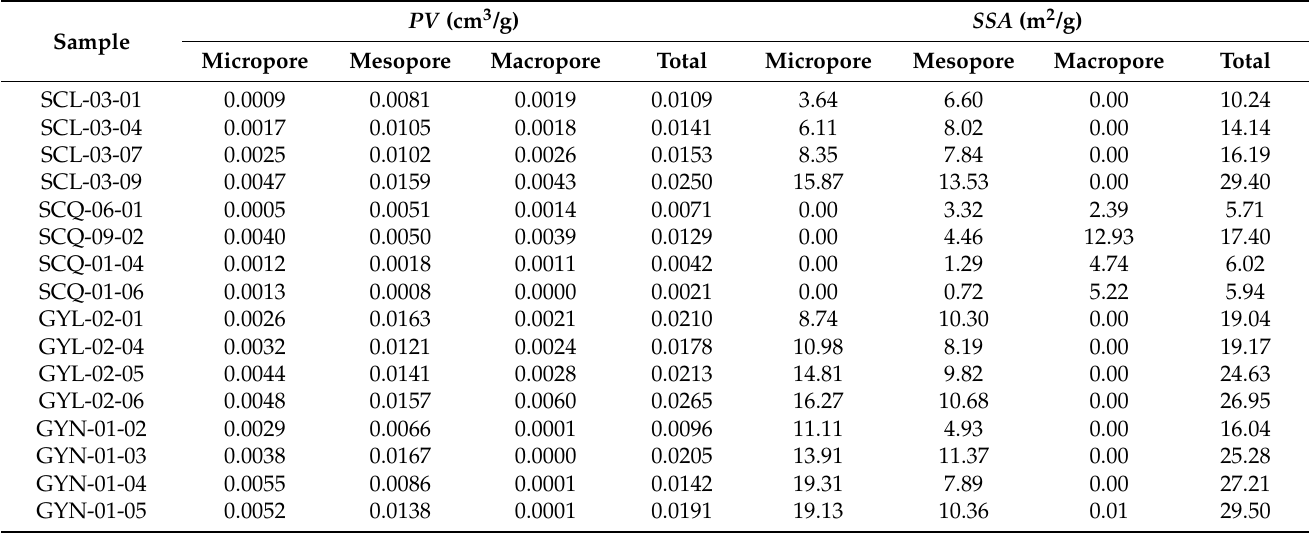
Table 2. PV and SSA of the Lower Paleozoic shales from the upper Yangtze plate.